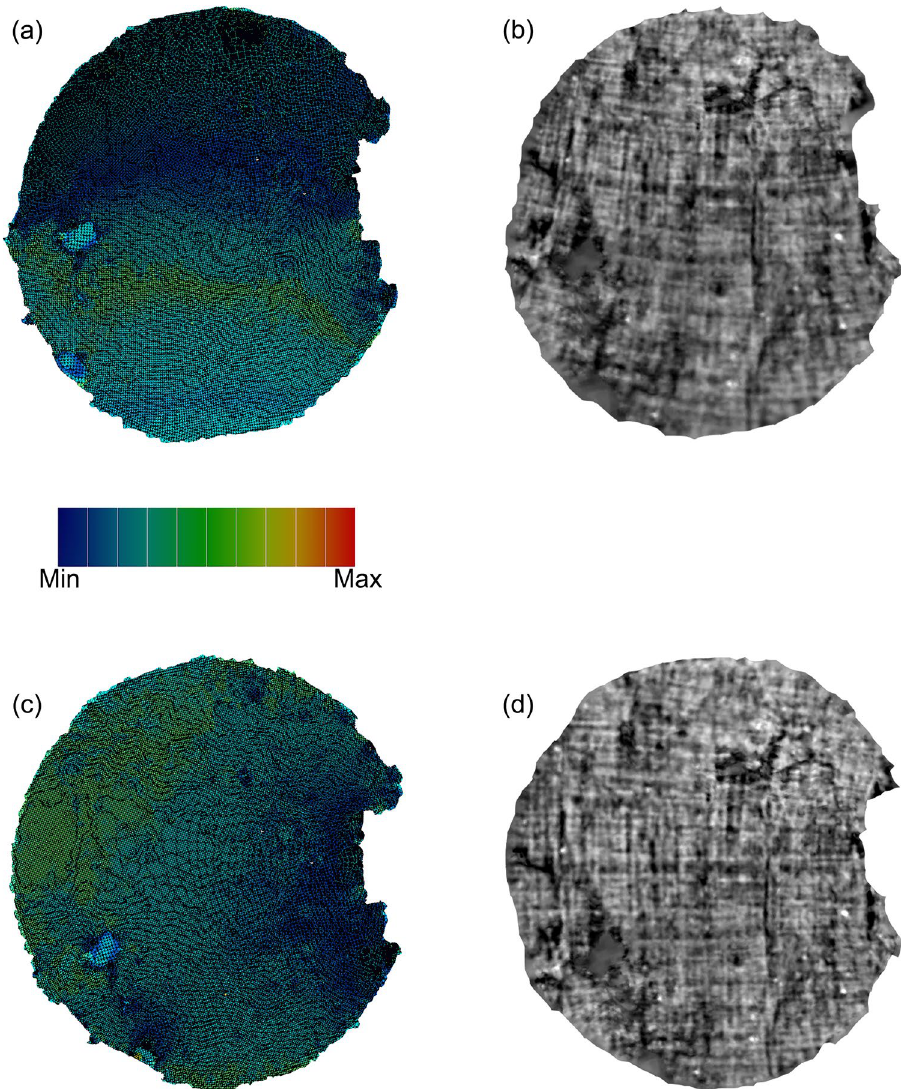
Figure 6. Comparison between different parameterization methods for the digital flattening of a sheet extracted from PHerc. 110 . 2D distribution pattern of area stretch ( a ) and 2D texture mapping ( c ) using LSCM; 2D distribution pattern of area stretch ( b ) and 2D texture mapping ( d ) using ABF. The color scale describes the degree of distortion in